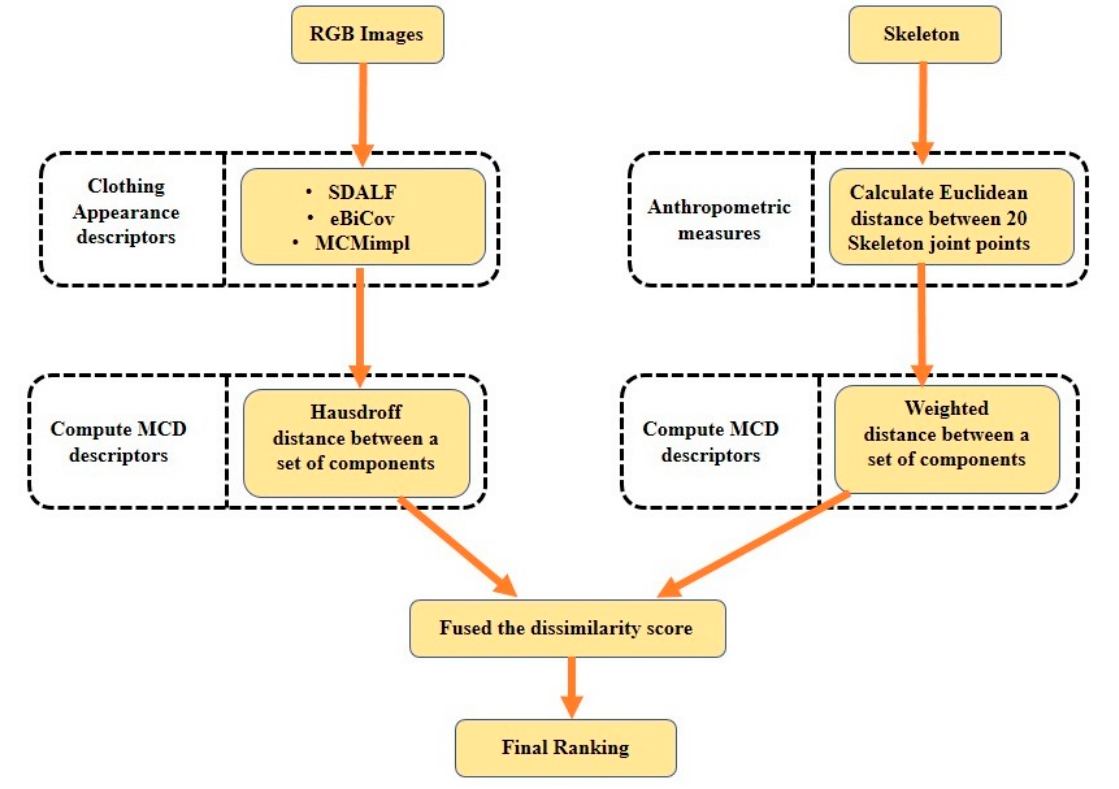
Figure 6. A flowchart of the RGB–skeleton information-based Re-ID framework.